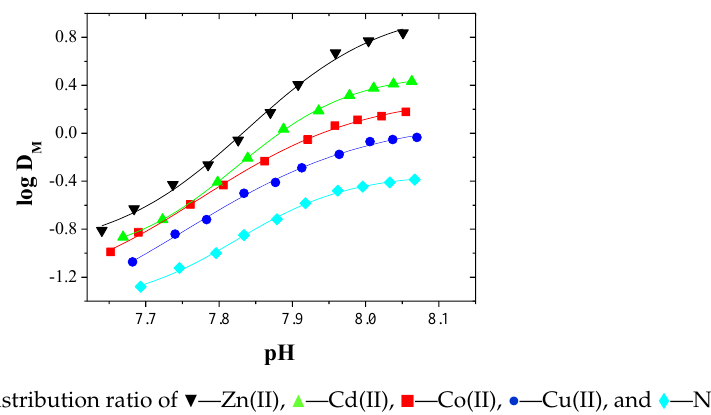
Figure 2. Logarithm of distribution ratio of (cid:72) —Zn(II), (cid:78) —Cd(II), (cid:4) —Co(II), • —Cu(II), and (cid:7) —Ni(II) complexes with EDAB-acac vs. equilibrium pH of the aqueous phase.